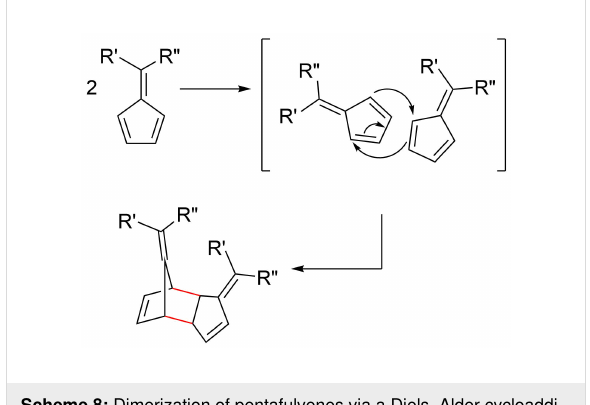
Scheme 8: Dimerization of pentafulvenes via a Diels–Alder cycloaddi- tion pathway whereby one fulvene acts as a diene and the